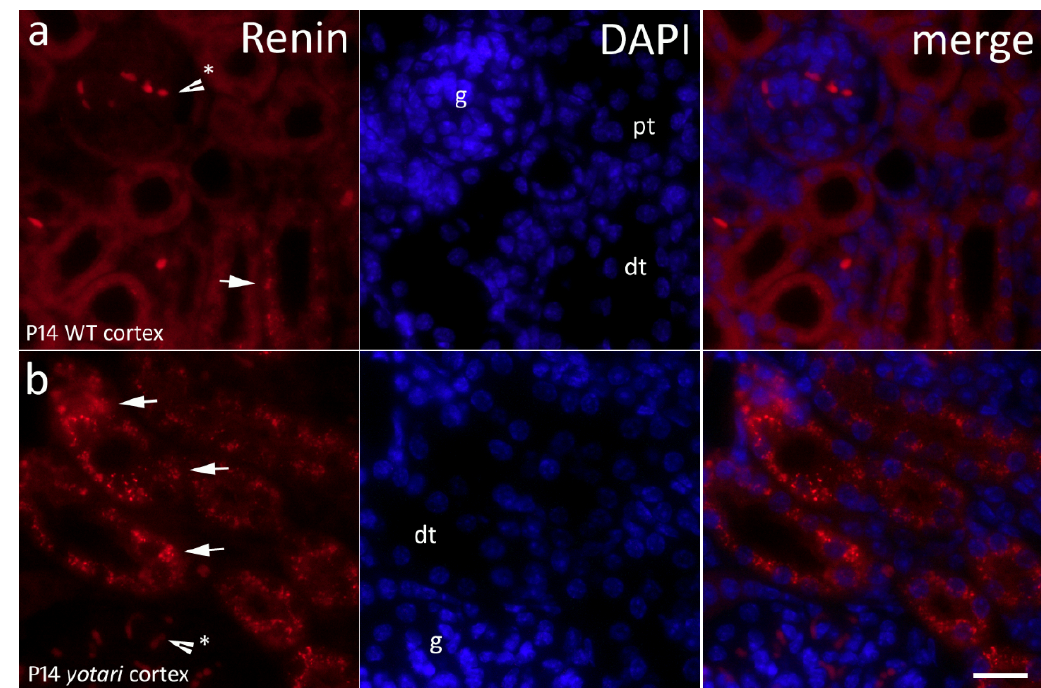
Figure 6. Immunofluorescence staining of postnatal yotari ( b ) and wild type ( a ) mouse kidneys with the Panx1 marker and co-expression of Panx1 and aSMA with DAPI nuclear staining. Expression of Panx1 (arrows), blood vessels (bv), glomeruli (g), proximal convoluted (pt) and distal convoluted tubules (dt). Co-expression of Panx1 and aSMA (arrowheads) can be seen on merged photographs. Autofluorescence of nephron tubules and erythrocytes (*), not to be mistaken with positive immunofluorescence staining. Scale bar is 20 μ m, refers to all images.